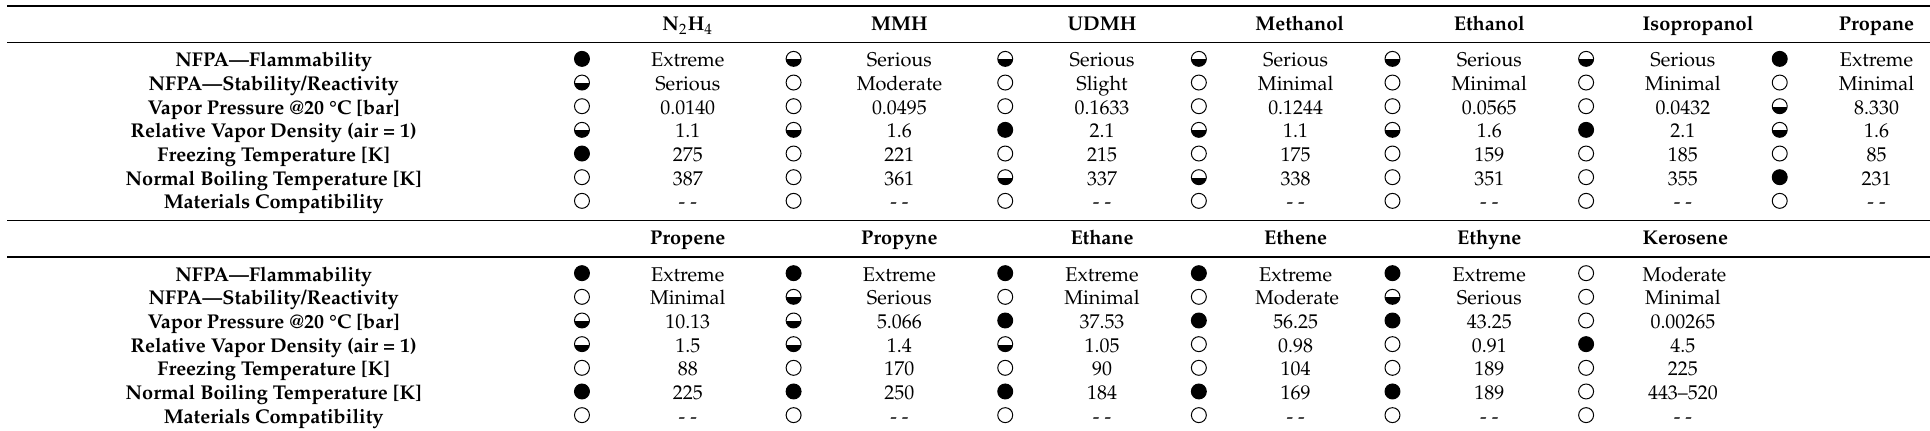
Table 12. Fuels handling and safety